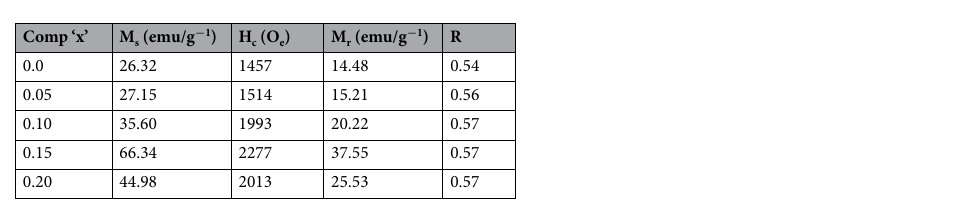
Table 4. The M s , H c , M r and R values, magnetic hysteresis measurements, of CBF for different ‘x’